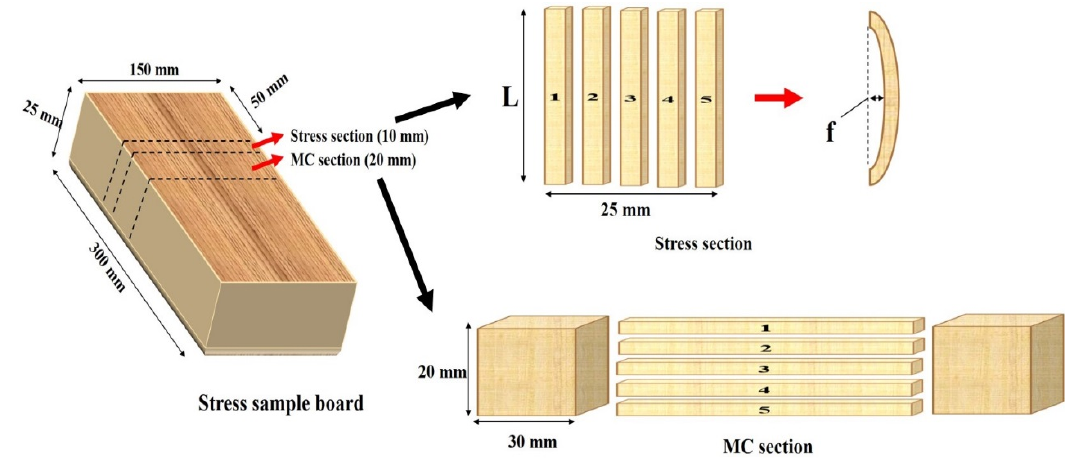
Figure 2. Testing of stress and MC sections.